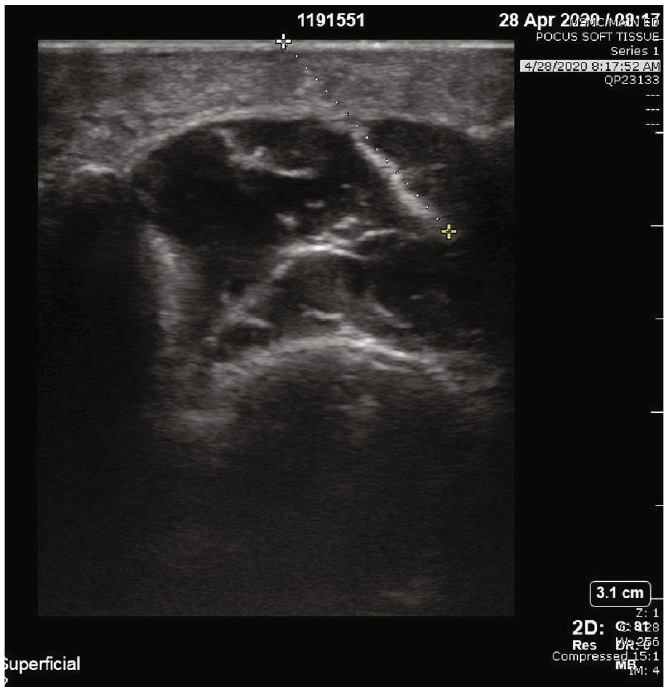
Figure 1: Initial point of care ultrasound demonstrates a thin linear hyperechoic structure with soft tissue swelling edema in the thenar region of the left hand.